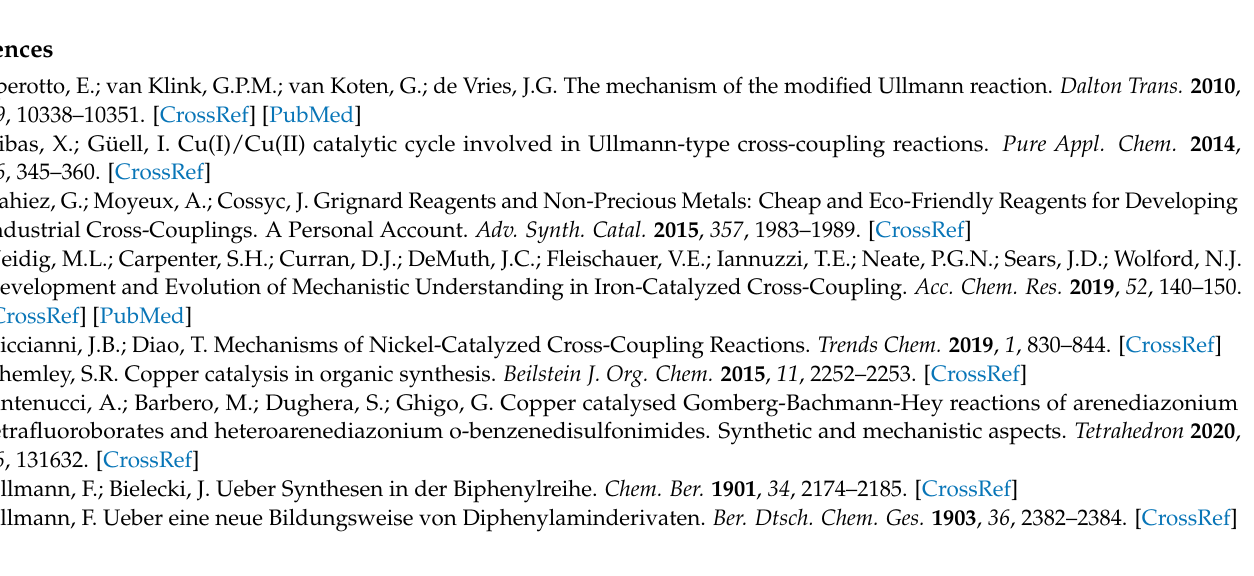
Figure S8: NMR spectra of N-( n -Hexyl)-3-Toluidine ( 3h ). Figure S9: NMR spectra of NMR spectra of N-( n -Hexyl)-4-Iodoaniline ( 3i ). Figure S10: NMR spectra of 2-[(4-Nitrophenyl)amino]Ethan-1-ol ( 3j ). Figure S11: NMR spectra of 1-( n -Hexyloxy)-4-Nitrobenzene ( 7a ). Figure S12: NMR spectra of Figure S14: NMR spectra of 2-Ethoxybenzo[d]thiazole ( 7d ). Figure S15: NMR spectra of Methyl Figure S16: NMR spectra of 3-Ethoxypyridine ( 7f ). Figure S17: n -Butyl 4-Nitrophenyl Sulfide ( 8a ). Figure S18: n -Butyl 4-Tolyl Sulfide ( 8b ). References [69–72] are cited in the supplementary